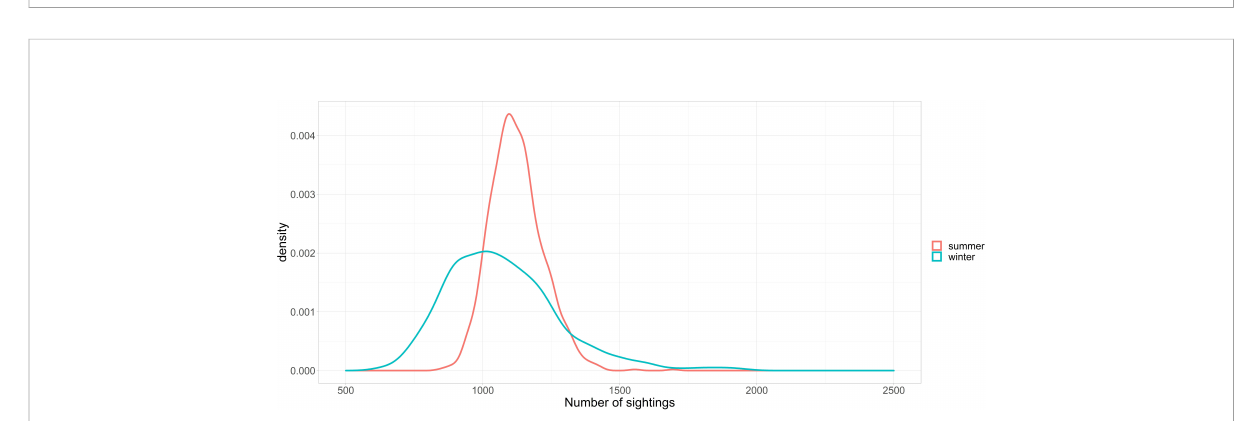
FIGURE 7 Distribution of the expected number of sightings over the whole area during summer (red) and winter